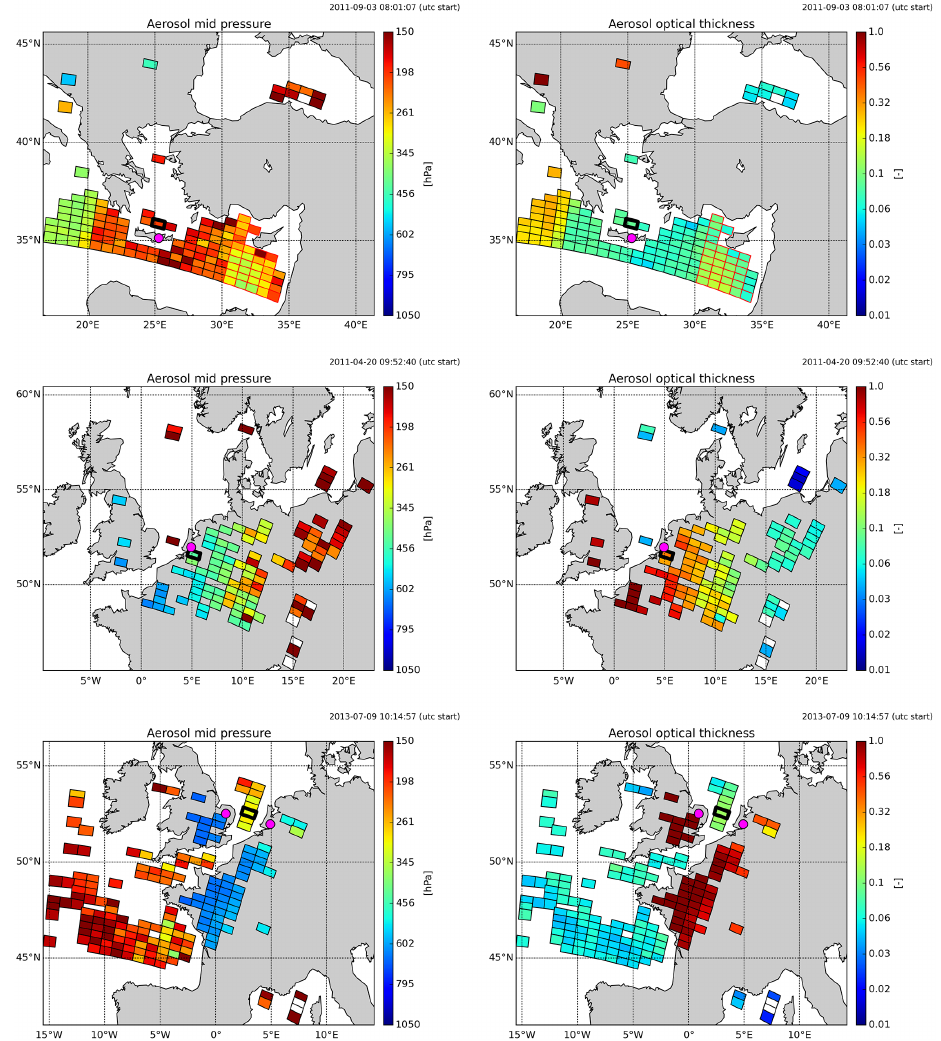
Figure 7. Retrieved aerosol layer mid pressure (left column) and aerosol optical thickness (right column) for the same GOME-2A scenes (rows) as in Fig. 6 when including the surface albedo in the state vector. Next to P mid and τ (760nm), the surface albedo A s and a temperature offset (cid:49)T are fitted. Other settings are the same as in Fig.